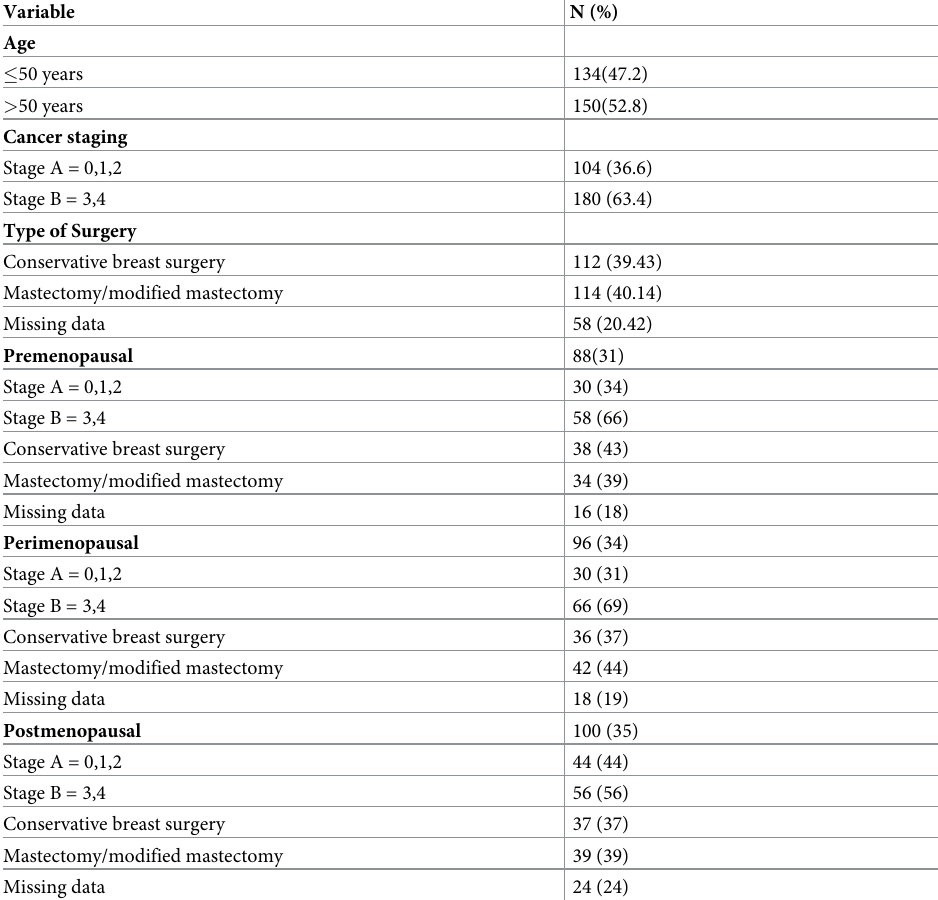
Table 1. Distribution of the participants according to the cancer staging, mode of surgery and menopausal